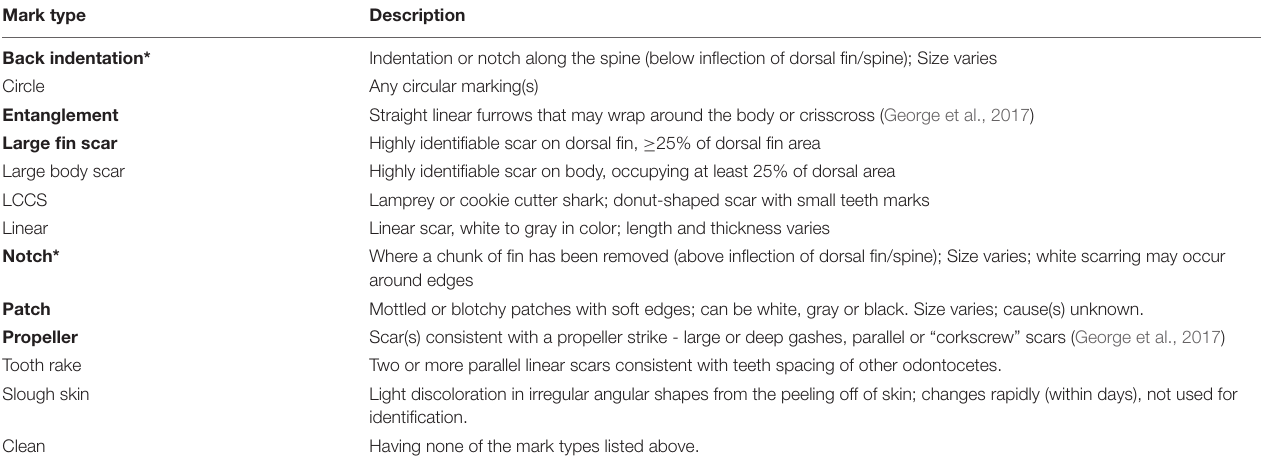
TABLE 2 | Mark types used as keywords for identification and matching, adapted from Gowans and Whitehead (2001). Mark type